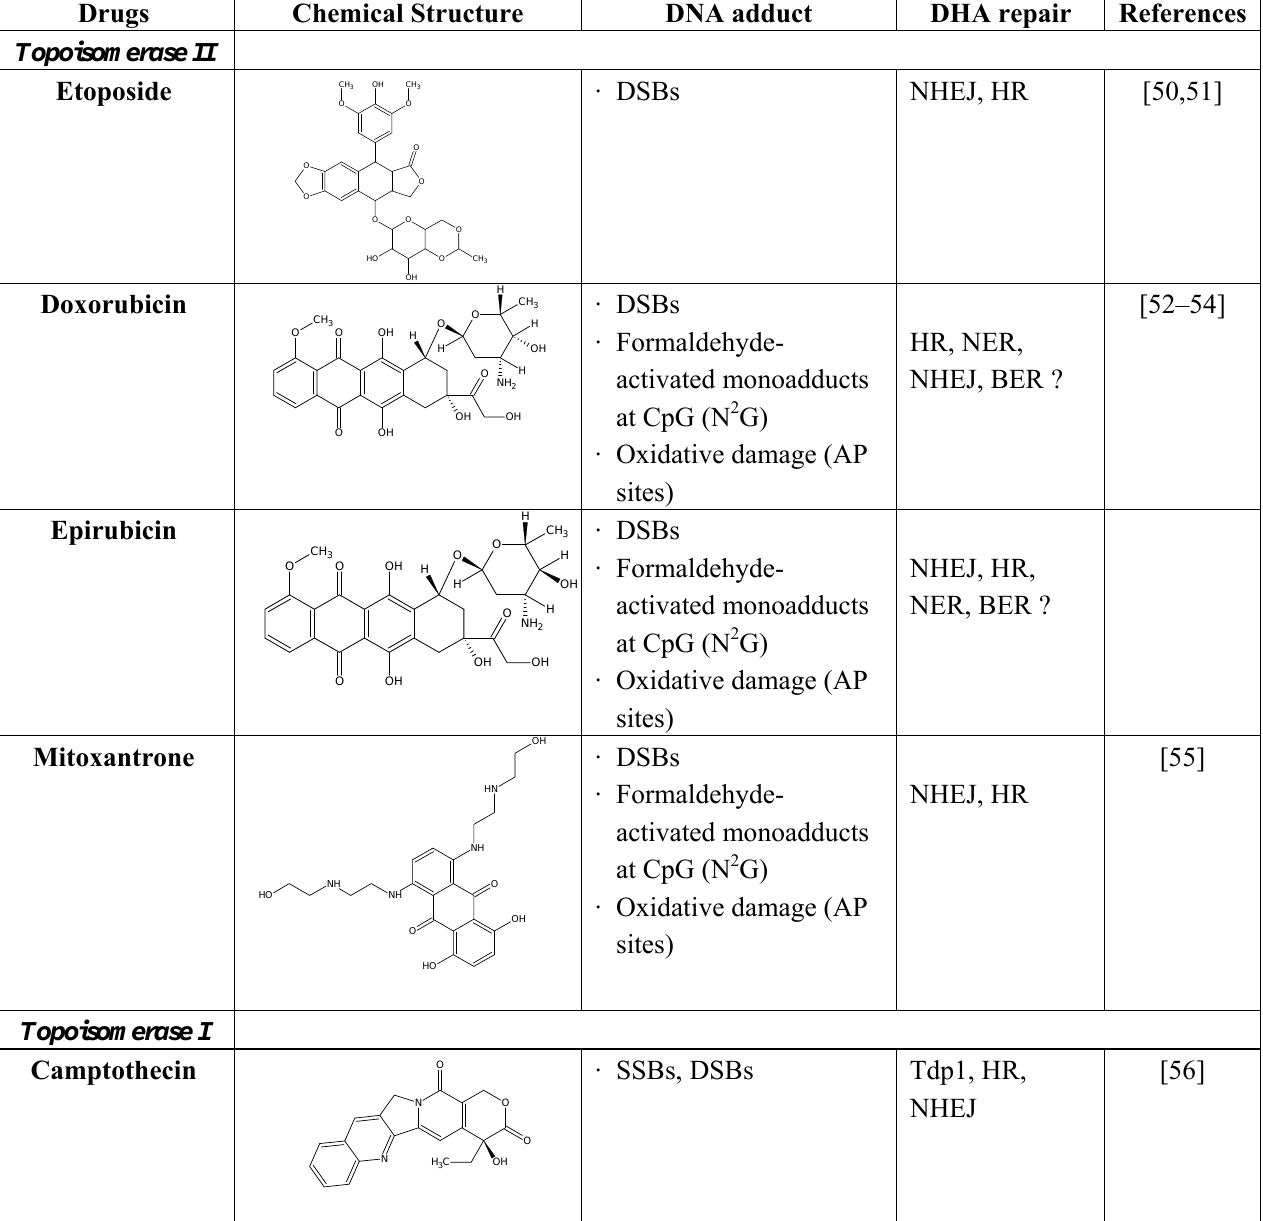
Table 3. Inhibitors of topoisomerases associated with the risk of occurrence of t-MN.